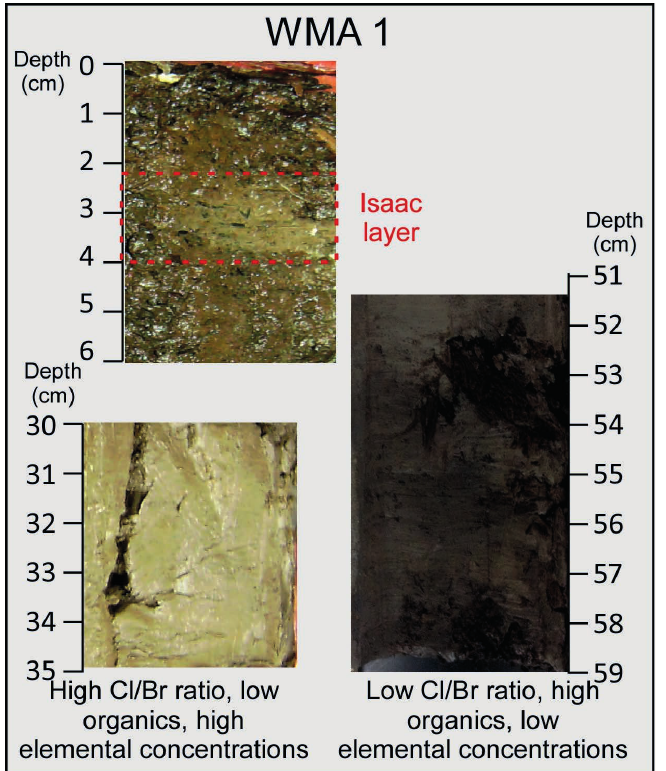
Fig. 4 Sedimentary differences. Photos show representative sediments from the organic unit (top), low- organic clay (bottom left), and slightly higher organic clay (bottom